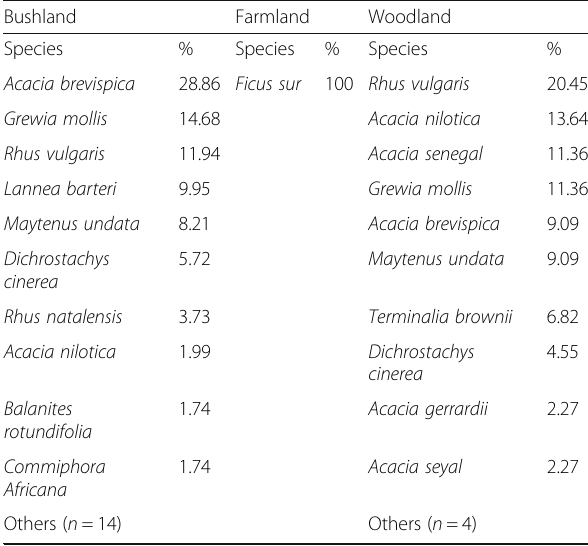
Table 2 Relative abundance of wood species among